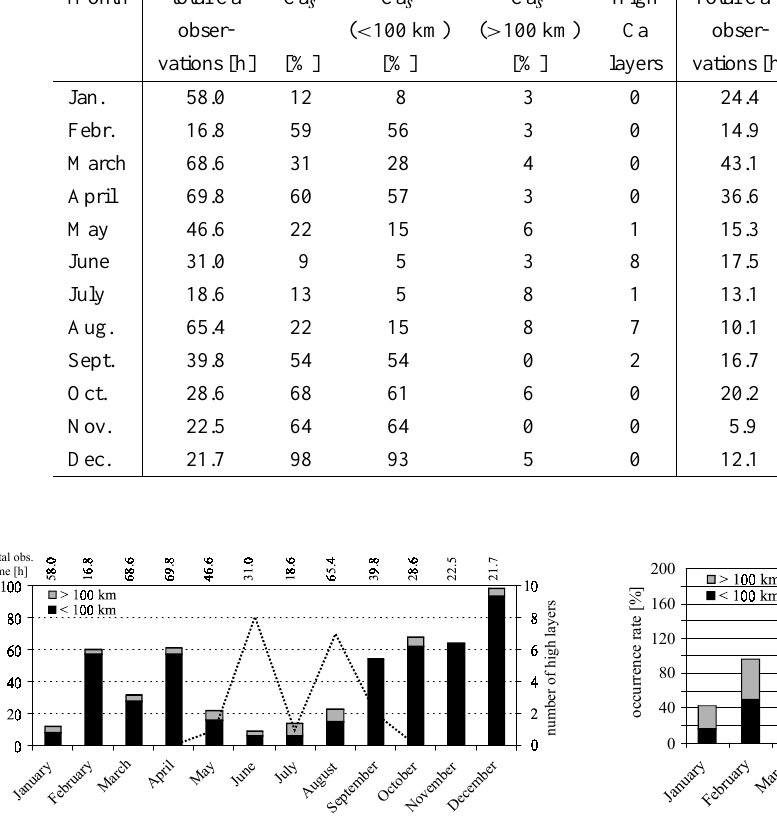
Fig. 10. Seasonal variation of the occurrence of sporadic ionized Ca + s layers (based on exact observation time). The portions of Ca + s above and below 100 km altitude are marked by different